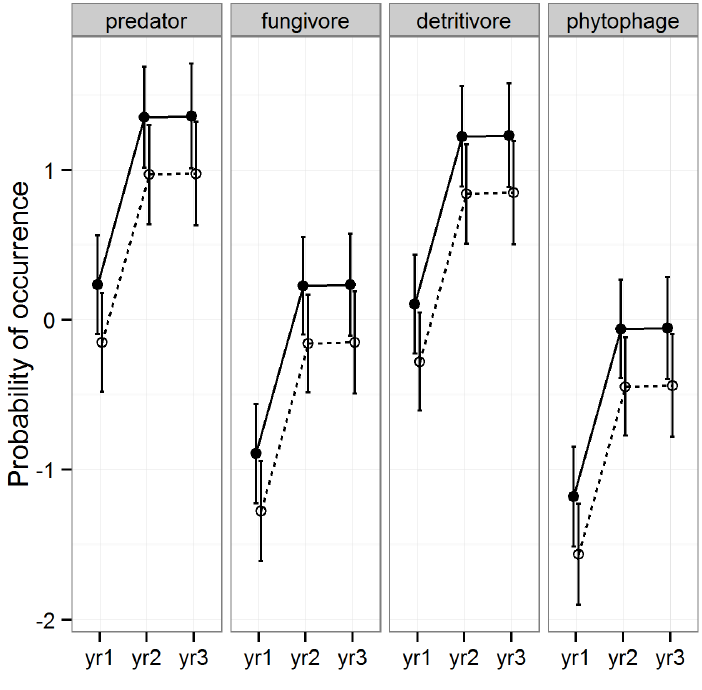
Figure 9. Predicted means and standard errors of Coleoptera occurrence during three years of seasonal pitfall trapping in pine plantations in North Florida against fixed effects from the most parsimonious model based on log-likelihood ratio tests; raked stands are displayed with open circles and dashed lines, intact stands with solid circles and lines; 2008 as yr1, 2009 as yr2 and 2010 as